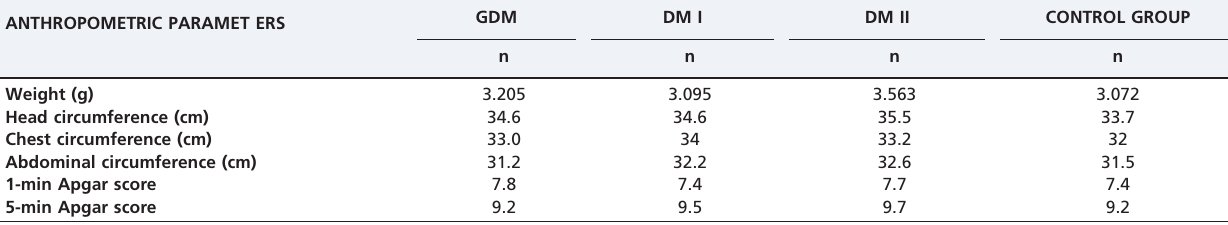
Table 6 - Characteristics of infants born to 62 women with or without (control of) diabetes mellitus, according to type, from Goiaˆnia, Central-West Brazil, between August 2009 and July